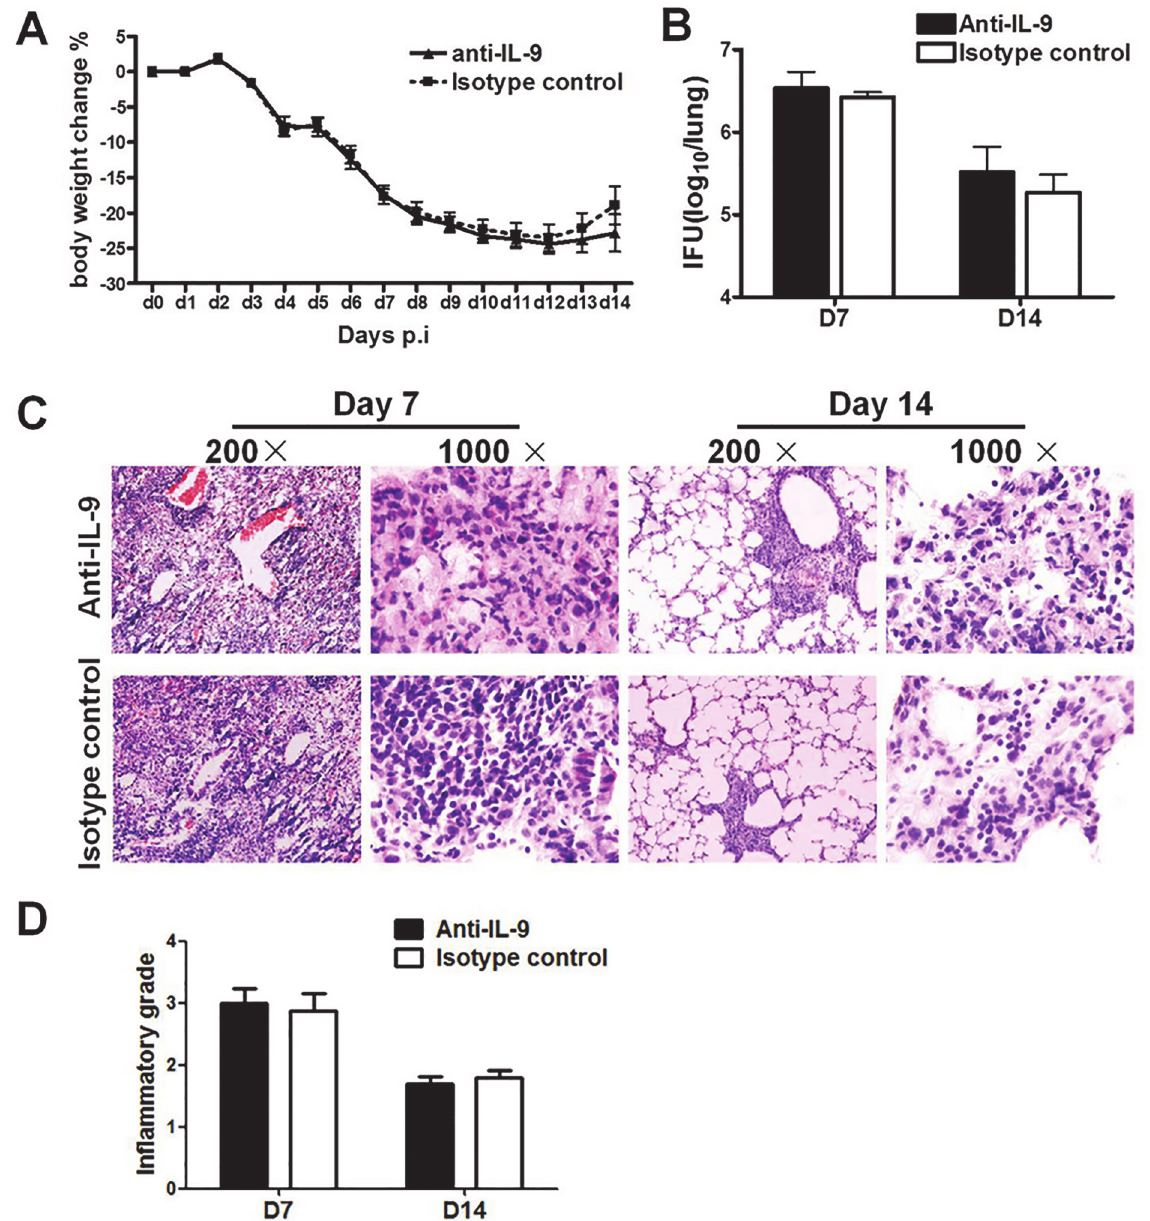
Fig 8. The neutralization of endogenous IL-9 has significant impact on infection process and histopathology in the lung. C57BL/6 mice were intranasally administered with 10 μ g of either anti-mouse IL-9 mAb or isotype control antibody at one day before and the same day of infection following by every 2 days thereafter. Mice were inoculated intranasally with 1×10 3 IFUs of Cm EBs. (A) The percentage of body weight changes in the two groups of mice. (B) Live chlamydial organisms (IFUs) in the lung on day 7 and day 14 after infection in each group. (C) The lung tissue sections from different experiment groups were tained with H&E and observed under light microscopy. (D) Semi-quantitative analysis of lung inflammation and damage (pathological score). Slides were examined by a blinded pathologist and the inflammatory grades were analyzed as described in Materials and Methods. One representative experiment of three independent experiments (four mice in each group in each experiment) is shown. The results are shown as mean ± SD.